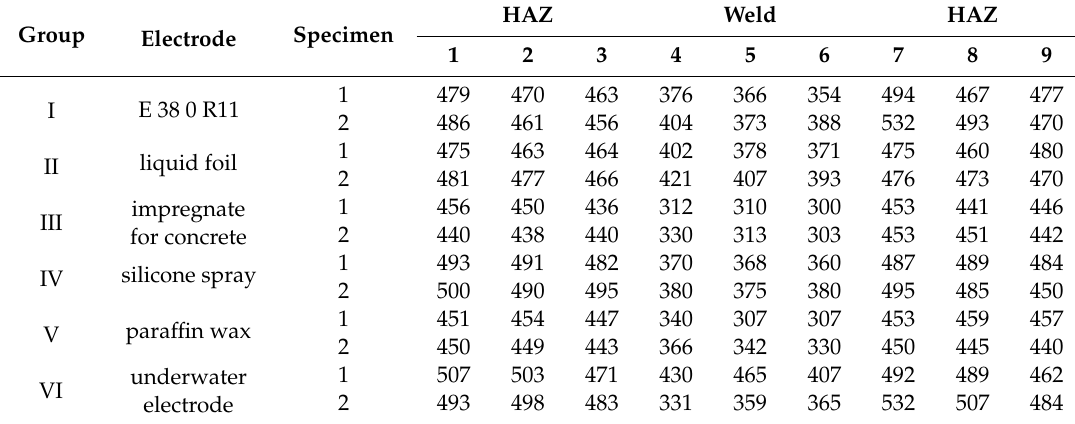
Table 6. The results of hardness HV10